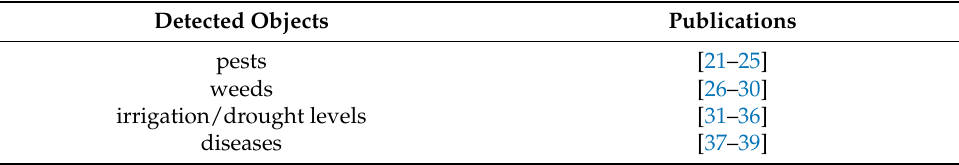
Table 1. Deep learning agricultural applications. Previous works applying deep learning in agricul- tural